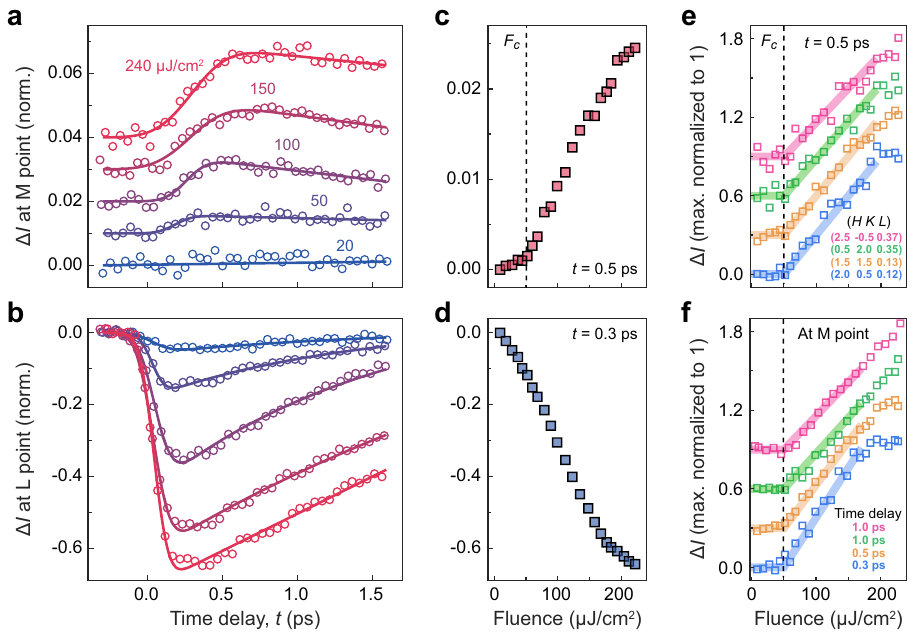
Fig. 4 Fluence-dependent dimension crossover of the CDW. a , b Time evolution of changes in integrated intensities ( Δ I ) at M and L points, measured at 88K. Intensity values are normalized by the averages before photoexcitation. Incident fl uences are labeled and color-coded. Solid curves are fi ts to an error function multiplied by an exponential relaxation and serve as a guide to the eye. For the M point, multiple diffuse peaks are used for enhanced signal-to-noise ratio. For the L (cid:1) (cid:3) 1 point, superlattice peak 2 1 is used. c , d Fluence-dependent changes in intensity at the M point at 0.5 ps time delay ( c ) and at the L point at 0.3ps time delay 2 2 ( d ). The vertical dashed line marks the critical fl uence, F c , above which the photoinduced intensity at the M point starts to rapidly increase. A separate critical fl uence is observed in the L point intensity at long time delay (see Supplementary Fig. 4 and Supplementary Note 4). e Fluence-dependent intensity change at various momenta along the M – L cut, measured at a fi xed time delay of 0.5ps. f Fluence-dependent intensity change at various pump-probe delays, measured at the M point. Red data points at 1.0ps were taken from a separate sample compared to the other data points. In e and f , traces are normalized so that the maximum change is 1; the traces are also vertically shifted by 0.3 for clarity. Curves are guides to the eye.